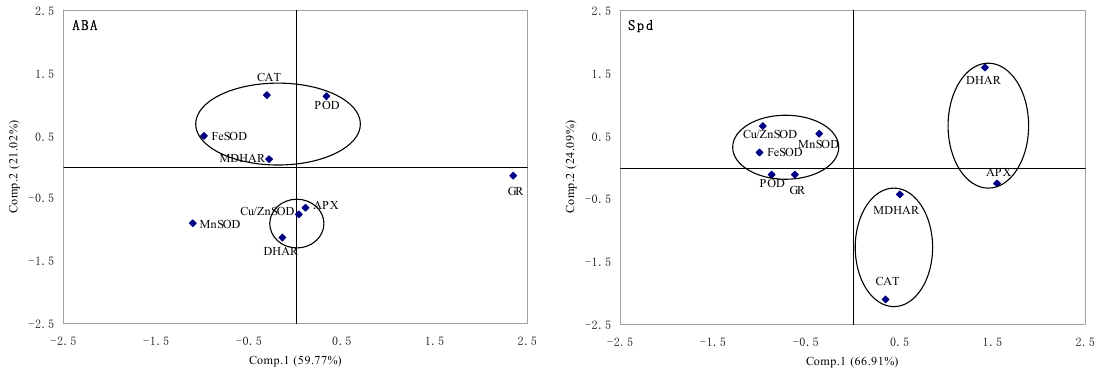
Figure 8. Quantitative real-time RT-PCR was used to analyze of ROS-scavenging enzyme genes expression treatment with Spd and normalized to β -actin . White clover leaves were sampled after 0, 3, 6, 12, 24, 48 and 72 h treatment. Data represent means of three replicates. Error bars representing standard errors and the different letters above the bars represent significant difference ( p < 0.05). Figure 3. Principal components analysis of ROS-scavenging enzyme genes expression under cold, drought, salt, heavy metal, ABA and Spd.